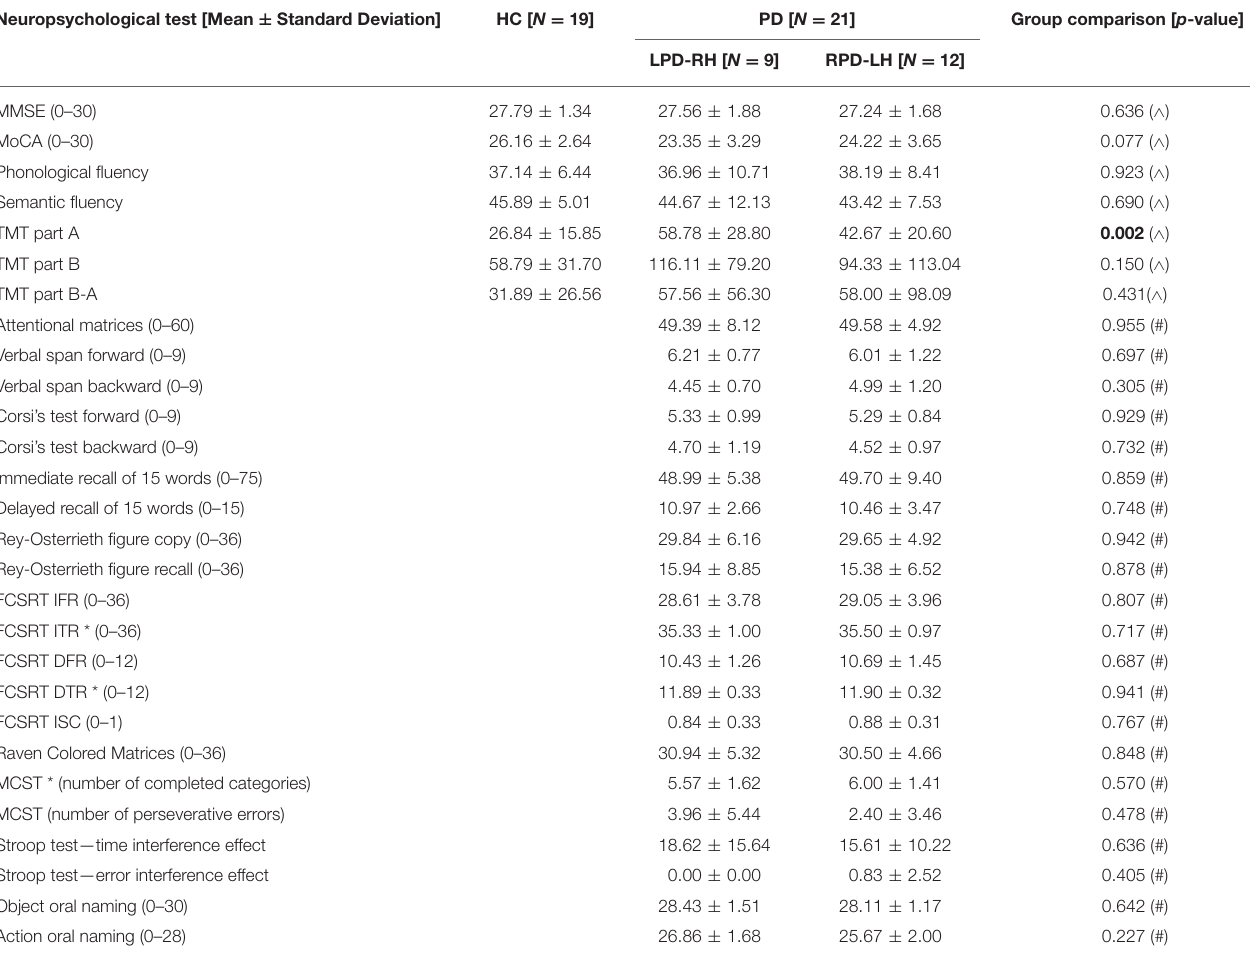
TABLE 2 | Adjusted and row scores (when adjusted scores are not available) obtained by HC (healthy controls) and PD (Parkinson’s disease) groups on neuropsychological tests. Neuropsychological test [Mean ± Standard